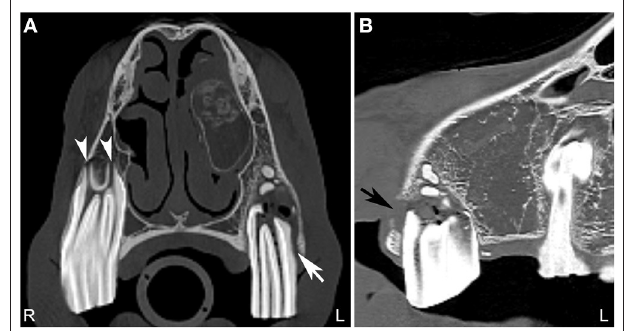
FIGURE 4 | Normal tooth and apical abscess. Transverse (A) and sagittal (B) computed tomography image at the level of the second maxillary premolar teeth displayed in a bone window of a 7-year-old Quarter horse, which had a fractured left third maxillary premolar tooth (Triadan 207) removed at 4 years of age. She recently developed a swelling in the area of the left maxilla. On the right side, the periodontal space surrounding the second maxillary premolar tooth (106) is of even width and the apical foramina (white arrowheads) are small. Good definition of the infundibular enamel and peripheral cementum of the right maxillary premolar tooth is noted (A) . On the left side (A,B) , the apical foramina are increased in size and the periodontal space is widened (white arrow). The left second maxillary premolar tooth (Triadan 206) roots are blunted and gas is noted in the soft tissue attenuating tissue adjacent to the abnormal root. An area of lucency it noted surrounding the abnormal 206. These findings are consistent with an apical abscess. Small, well-defined mineral attenuating structures are noted at the distal aspect of the left abnormal maxillary premolar tooth, likely representing multiple small cemental depositions (“cement pearls”) secondary to chronic apical infection. At the rostral aspect of this tooth, a loss of the maxillary bone adjacent to the tooth root is noted (black arrow). An ovoid, soft tissue attenuating, small mass lesion surrounded by a thin-mineral attenuating rim with central amorphous mineral attenuating structures is noted in the left nasal cavity. This mixed attenuating lesion extends to the left maxilla at the site of the previous surgery for tooth removal and is suggestive of a chronic inflammatory process. This lesion displaced, but was not originating from the ventral nasal conchal bulla. The 207 is absent. L, left; R, right.